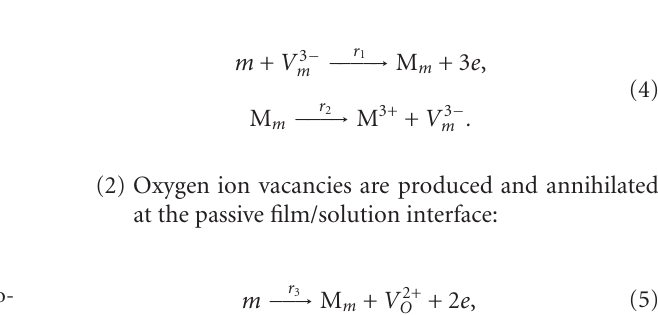
Figure 5: Schematic representation of five electrochemical pro- cesses which occur within the passive film according to the